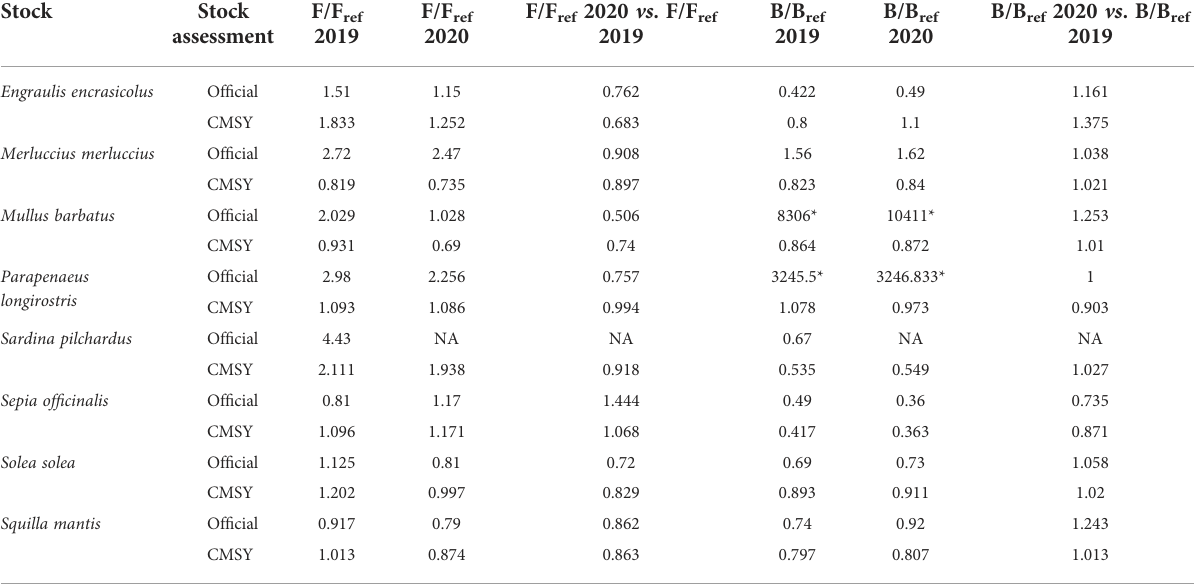
For the of fi cial models, 2019 sources for Sepia of fi cinalis, Merluccius merluccius, Squilla mantis is (FAO, 2021a), common sole in 2019 (FAO, 2021b), Parapenaeus longirostris and Mullus barbatus(STECF,2020b),EngraulisencrasicolusandSardinapilchardus(FAO,2021c)and2020forSepiaof fi cinalis,Merlucciusmerluccius,Squillamantisandcommonsole(FAO,2022a), Parapenaeus longirostris and Mullus barbatus (STECF, 2021b), Engraulis encrasicolus, and Sardina pilchardus (FAO, 2022b). *Unit of measure is SSB; NA, not available. Fref and Bref correspondtotheestimatedF MSY andB MSY valuesforthestockassessmentdevelopedwithCMSY,whereasFrefandBreffortheof fi cialstockassessmentsagreewiththoseof fi ciallyselected and set out in the reports cited